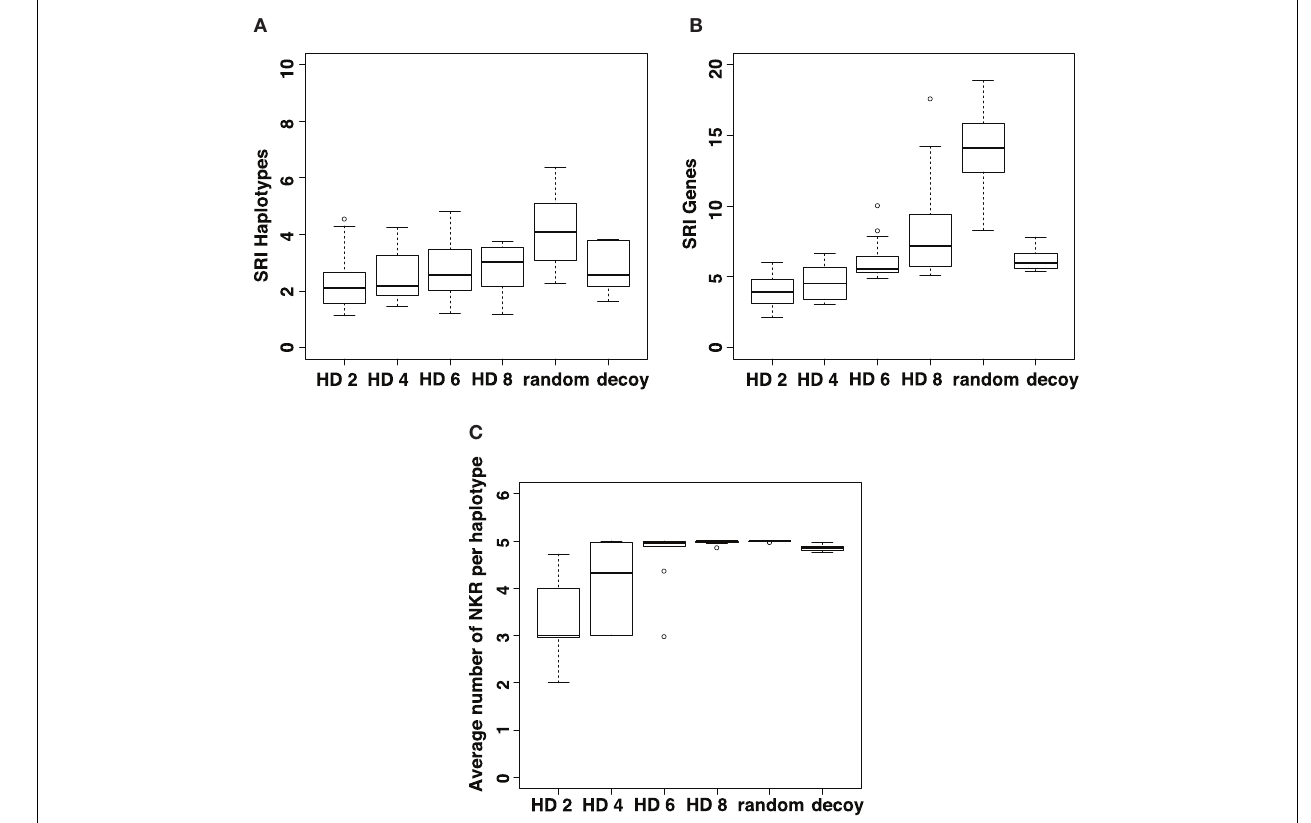
viruses evolving MHC-decoys. Additionally, we estimate the expansion of the iNKR haplotype, by measuring the number of loci per haplotype (C) . The selection pressure for polygenicity is smaller in populations with highly structured MHC molecules. The boxes represent the interquartile range, and the bold horizontal lines represent the median taken out of 10